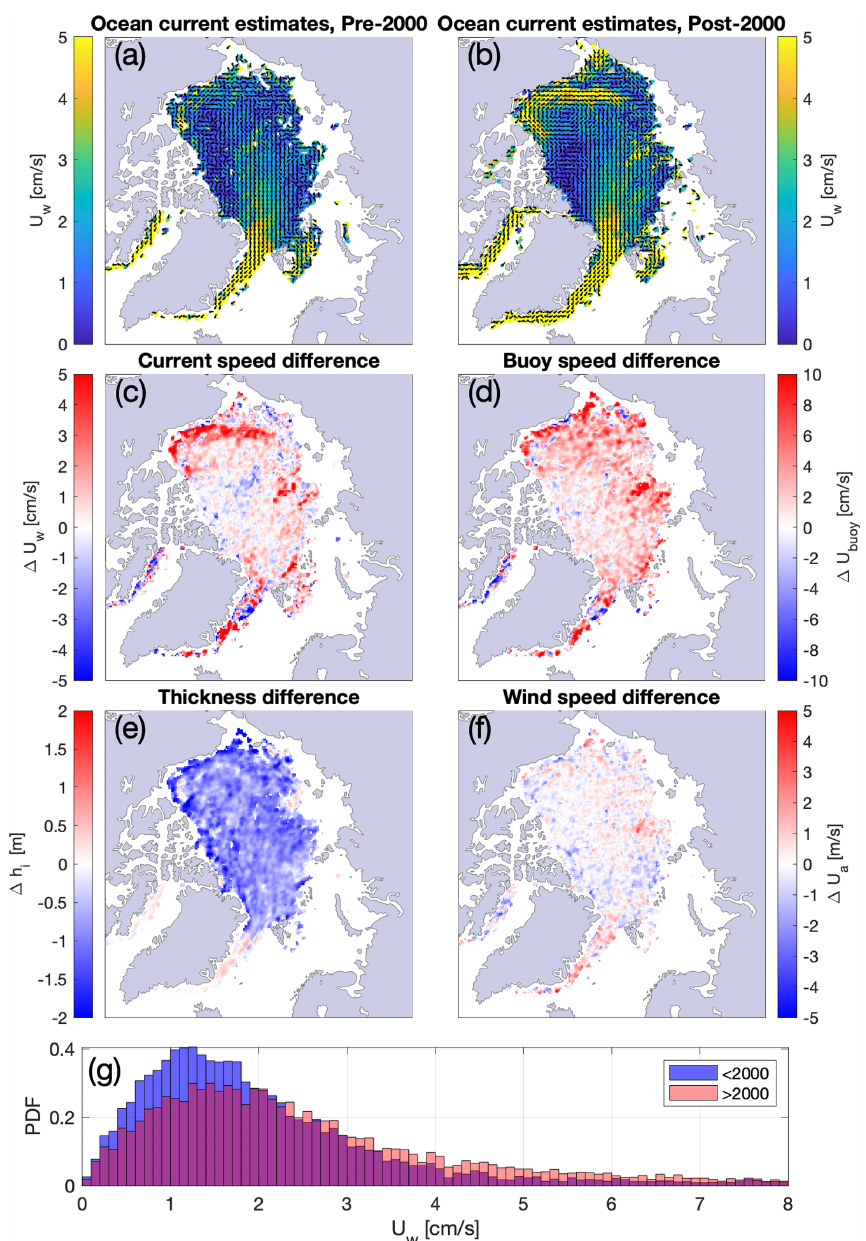
Figure 9. Estimates of the oceanic surface currents for the period covering (a) 1979–2000 and (b) 2001–2019. Maps of the difference between the later and earlier part of the record (post-2000 minus pre-2000) are presented for the following fields: (c) surface oceanic currents speed, (d) IABP buoy-derived ice drift speed, (e) ice thickness from PIOMAS, and (f) 10m wind speed from ERA5. The distribution of current speed for the pre- and post-2000 periods is presented in panel (g)